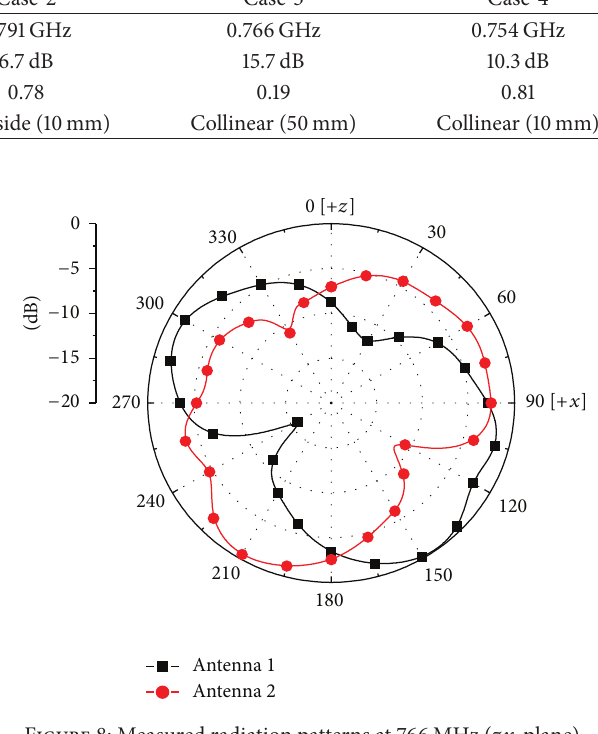
Figure 6: Measured 𝑆 -parameters.